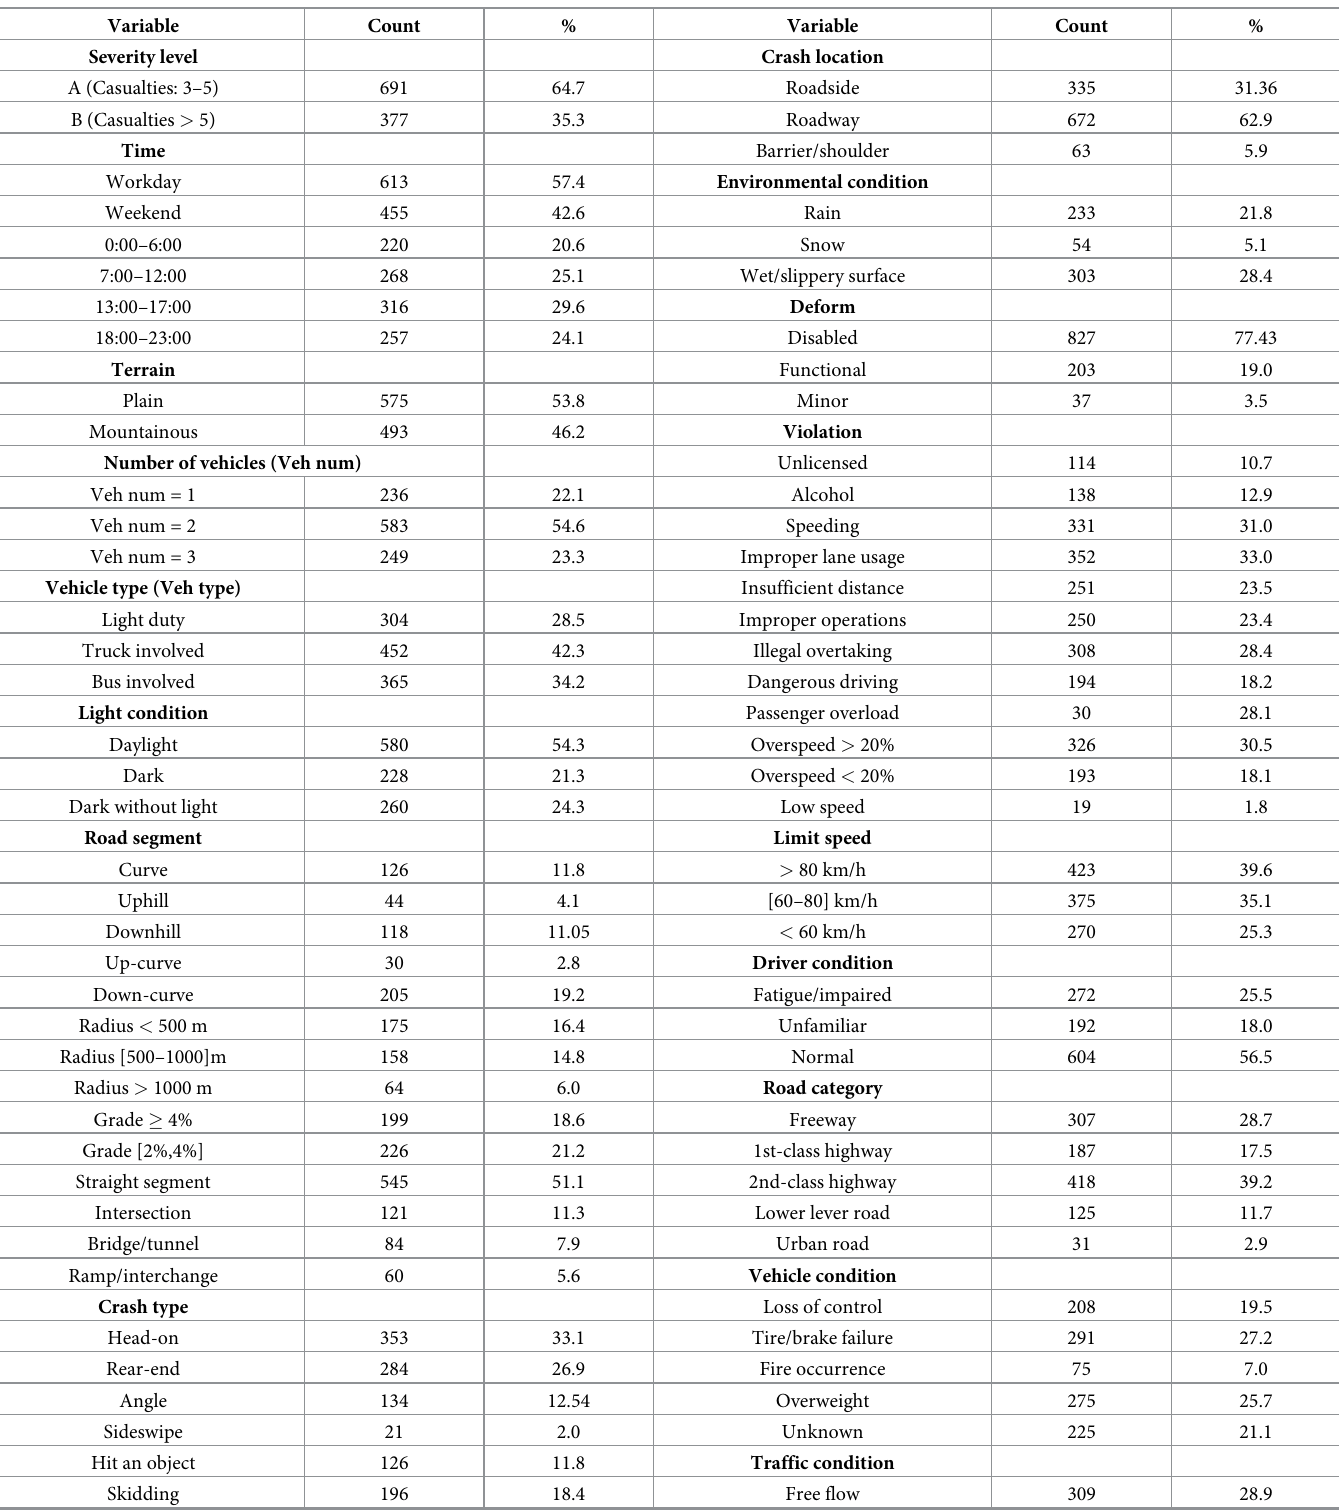
Table 1. Descriptive statistics of crash